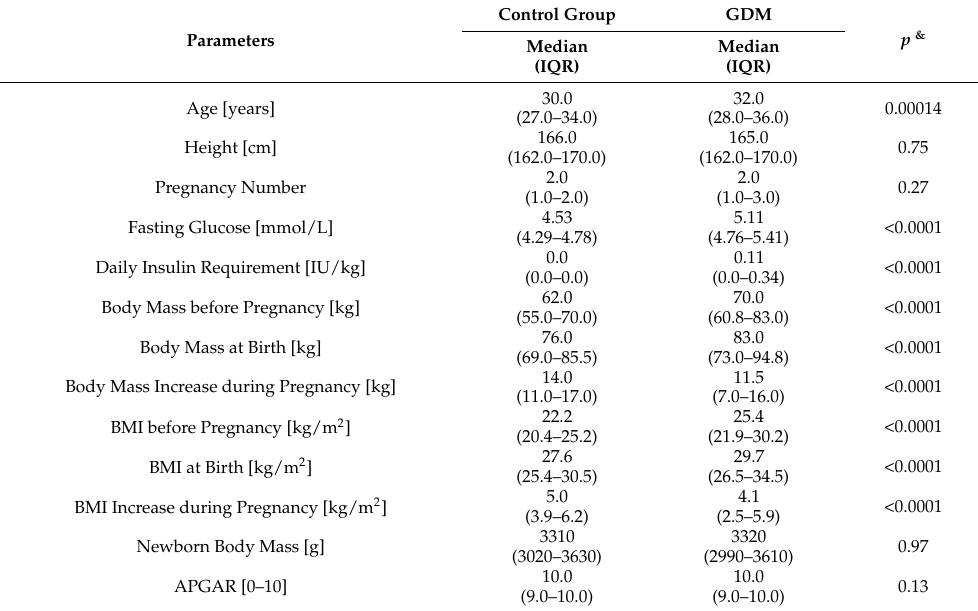
Table A1. Clinical characteristics of women included in the analysis of COBLL1 and IRS1 gene polymorphisms.